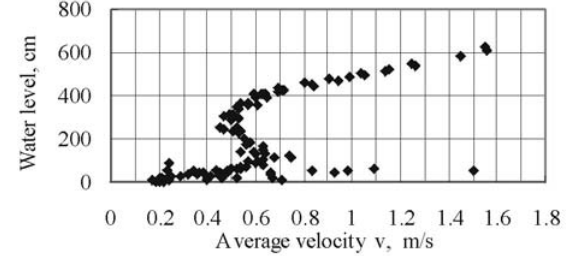
Fig. 5 . Water velocity dependence on water levels and vegetation (measured in the Nev ė žis riverbed at the Vilainiai gauging-station at cross-section